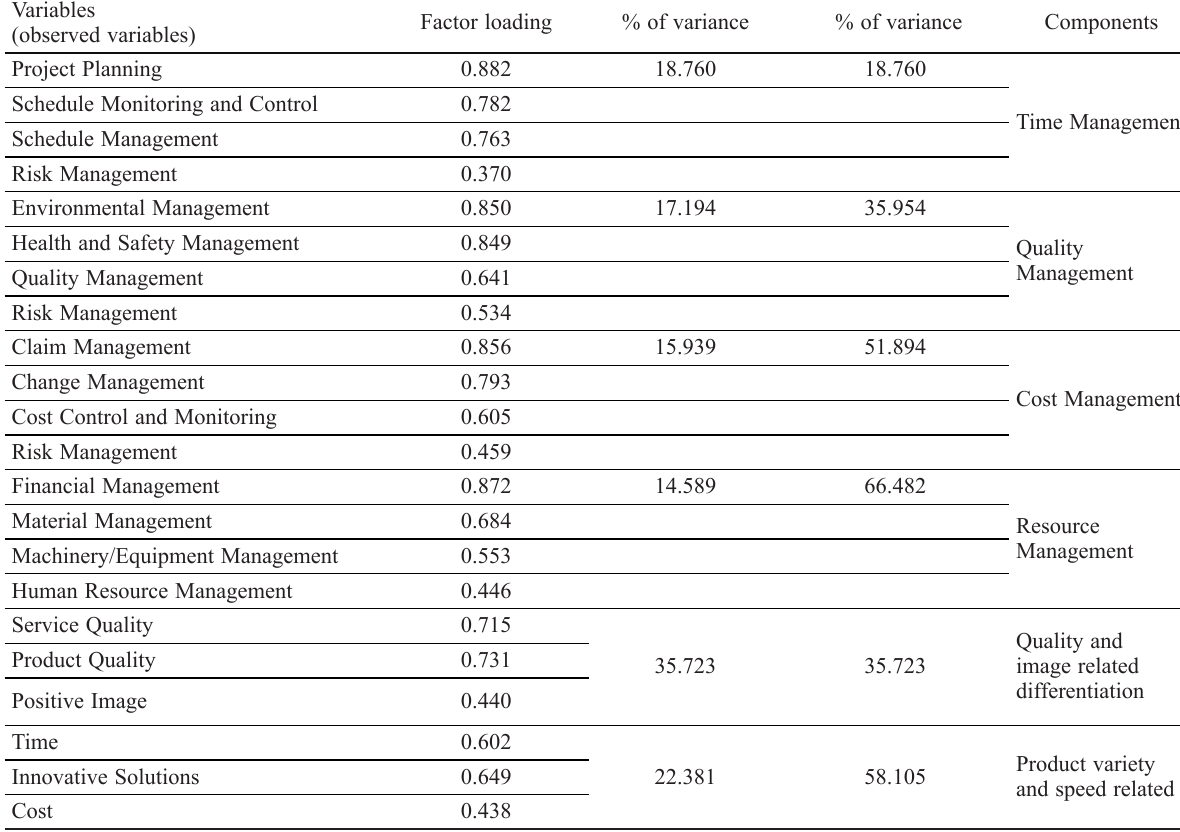
Table 1. Result of factor analysis of exogenous and endogenous latent variables Variables (observed